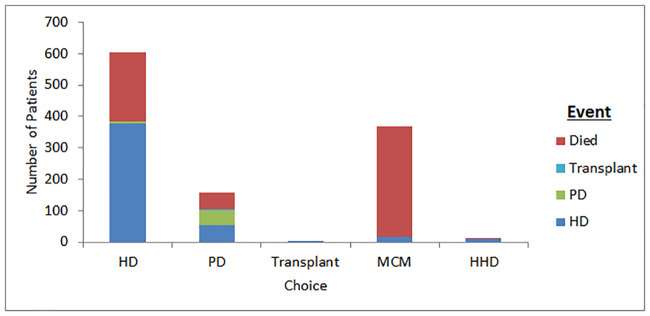
First event where event occurs.